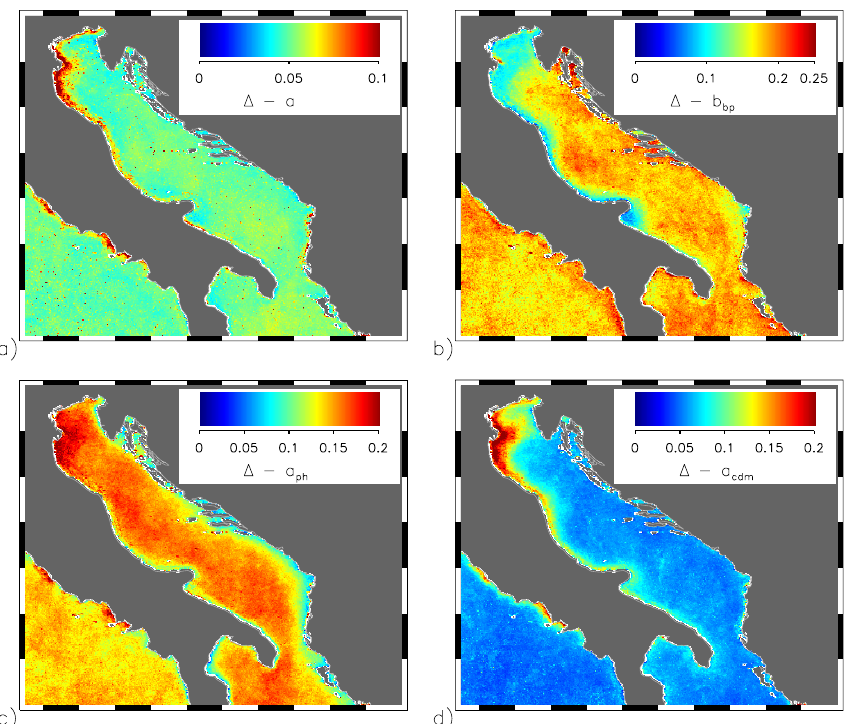
Fig. 4. Maps of 1 obtained comparing (a) a S (490) versus a A (488), (b) b bp (555), (c) a ph (443), and (d) a cdm (443) (using N = 1454 days).